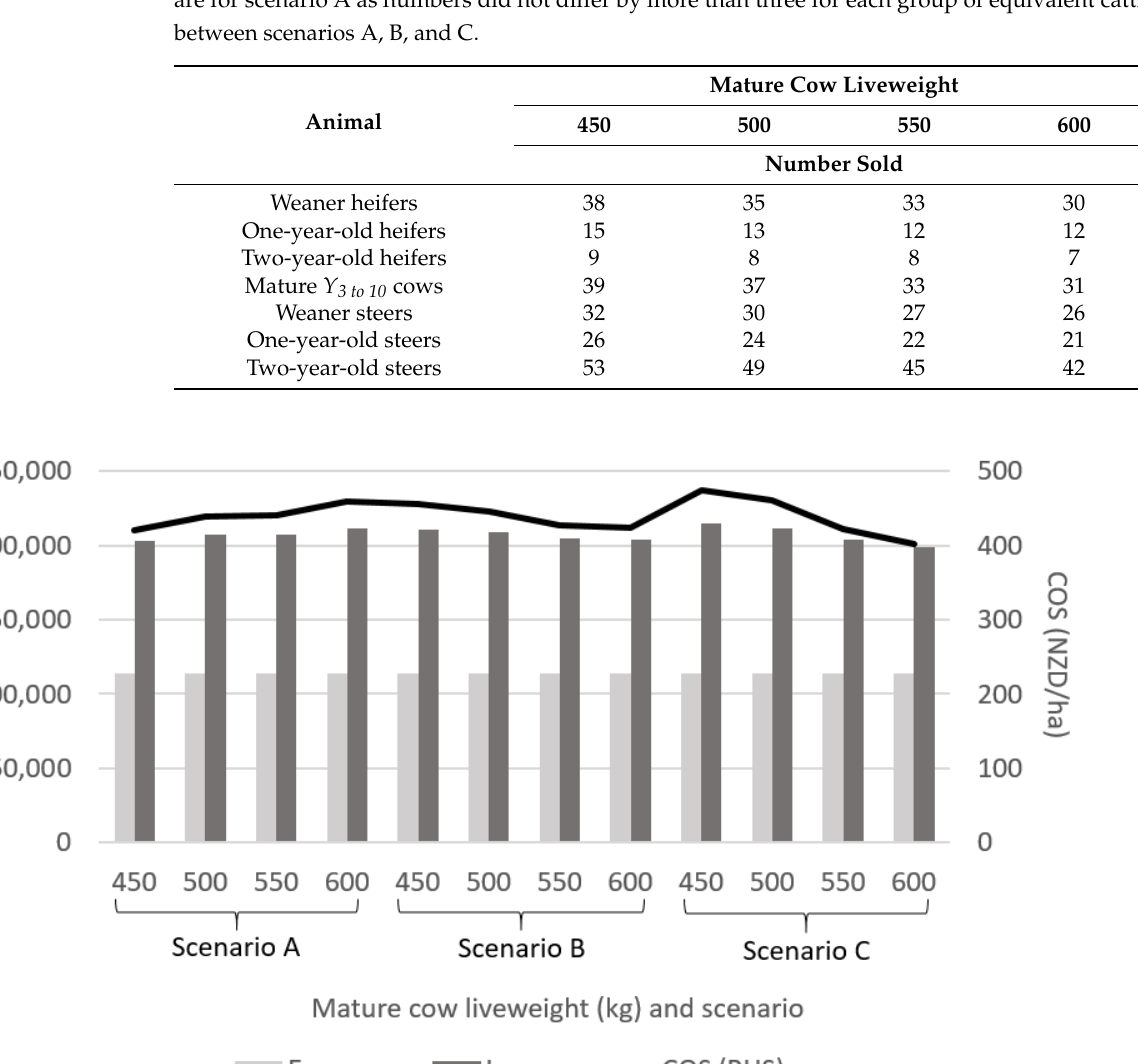
Figure 4. Income from cattle sales, beef enterprise expenses, and beef enterprise cash operating surplus (COS, on the right hand side y axis), with varying mature cow liveweight for scenarios with (A) a constant ratio of birth and weaning weights to mature cow liveweight, (B) decreasing ratios of birth and weaning weights to mature cow liveweight as mature cow liveweight increased, and (C) the ratio of birth weight to mature cow liveweight decreased as mature cow liveweight increased and constant pre-weaning growth rates of 1.00 kg/day.